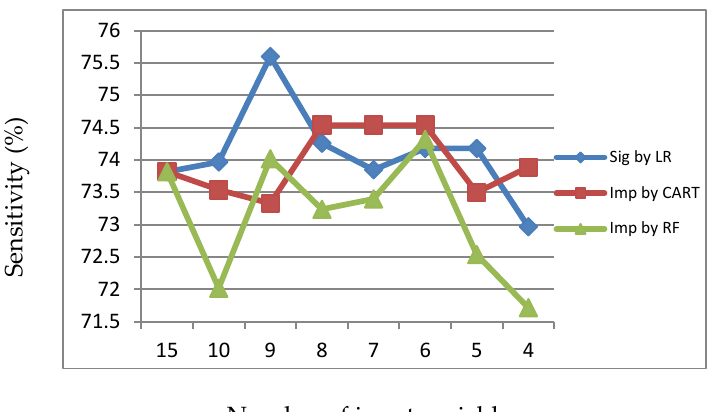
Figure 14. Sensitivity of CART with input of significant or important variables.